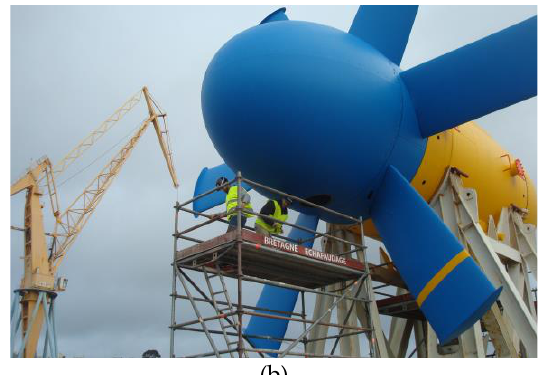
Fig. 9. Installation of data logger on Sabella turbine blade before immersion.